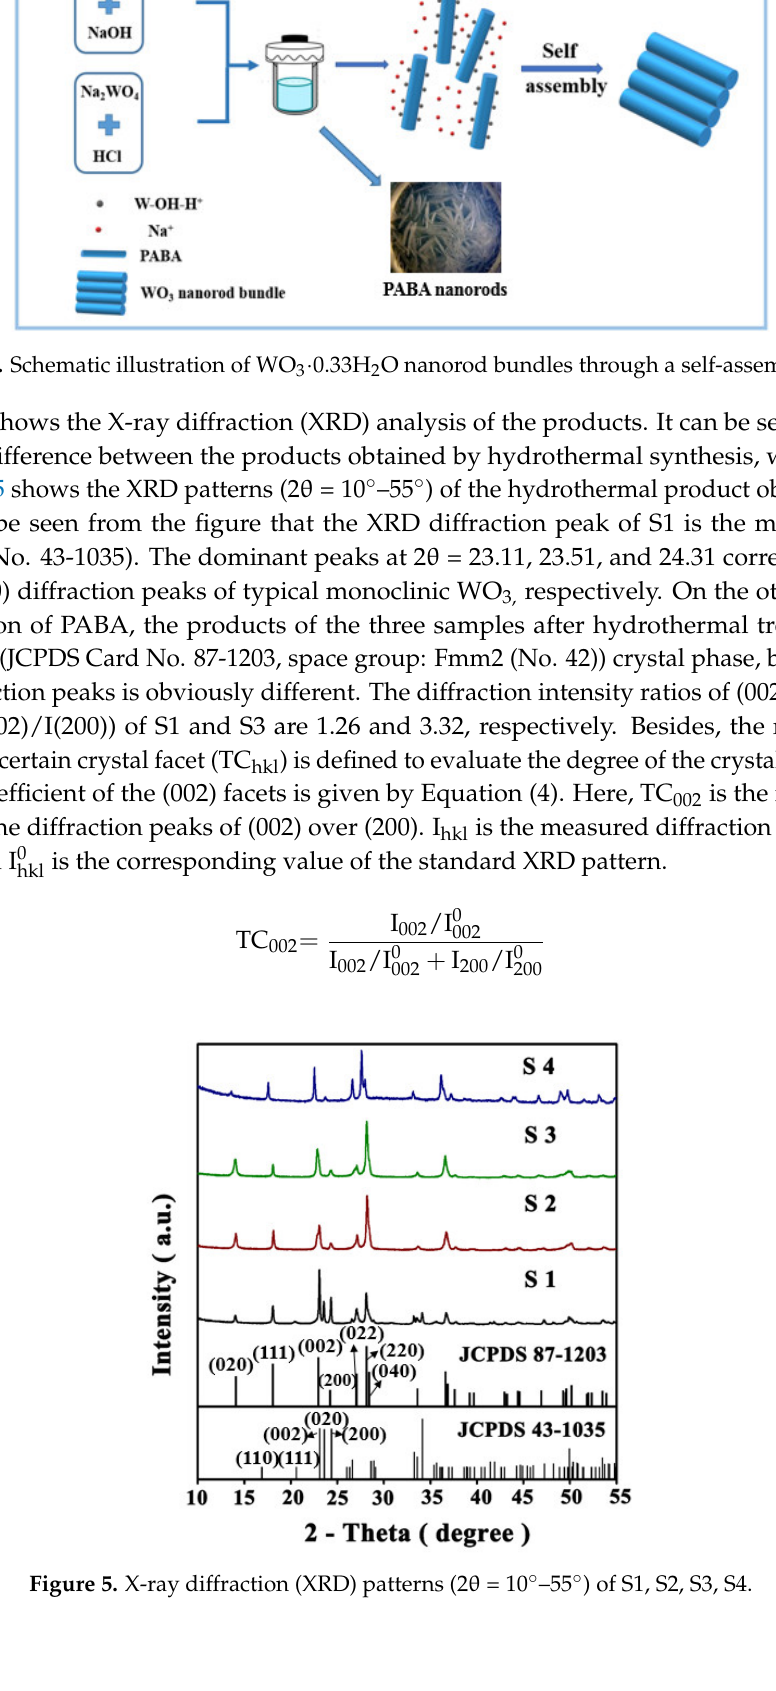
Figure 5. X-ray diffraction (XRD) patterns (2θ = 10°–55°) of S1, S2, S3, S4.